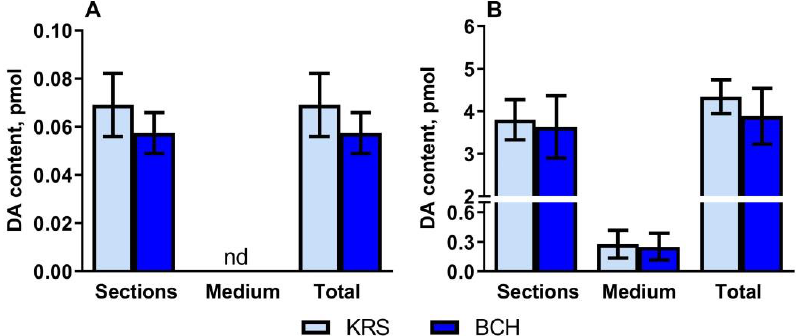
was not detected in the medium (Figure 2A).